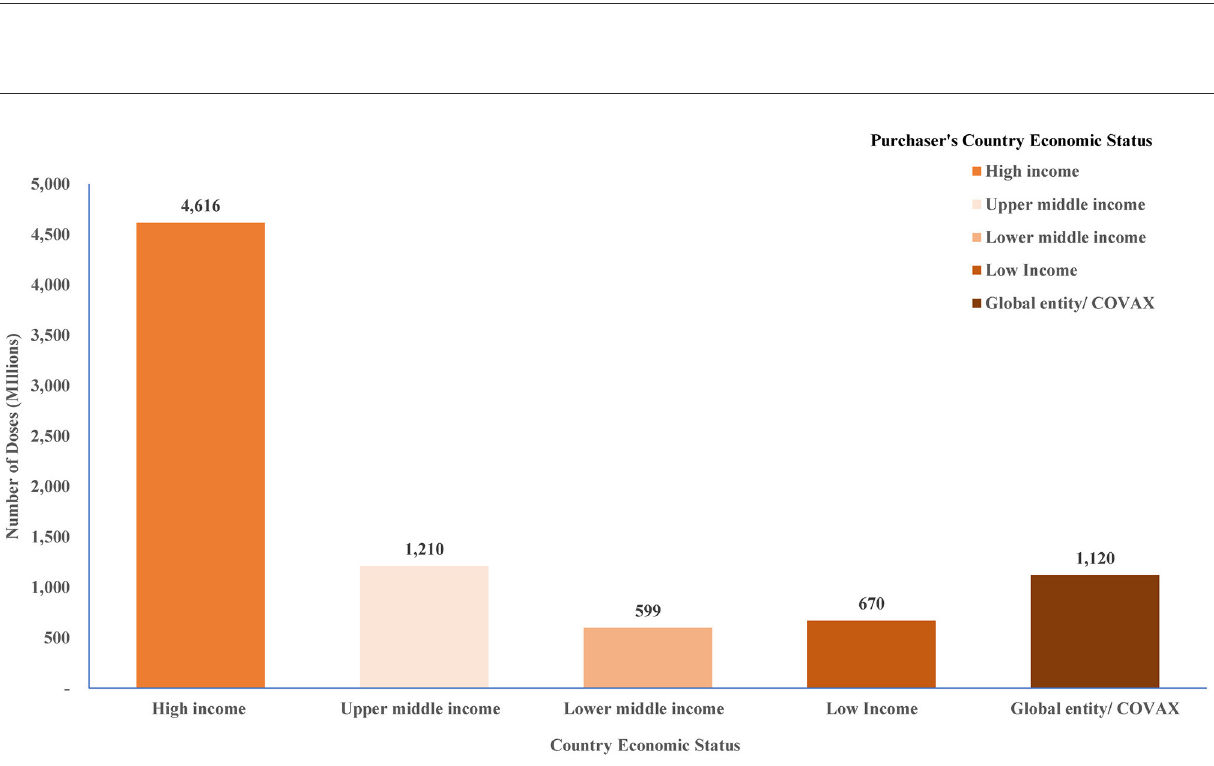
FIGURE2 Confirmed number of doses purchased by country income level classification. Source: Duke Global Innovation Center (21).